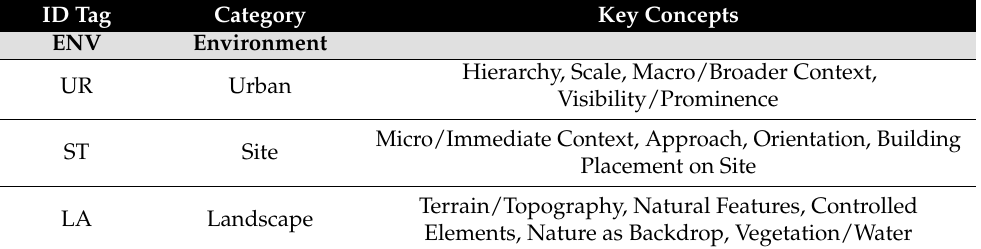
Table 3. Category definitions and key concepts for performing graphical analysis. Researchers begin their analysis at the macro environmental scale, work their way to the building’s exterior form, and finish with the interior spatial